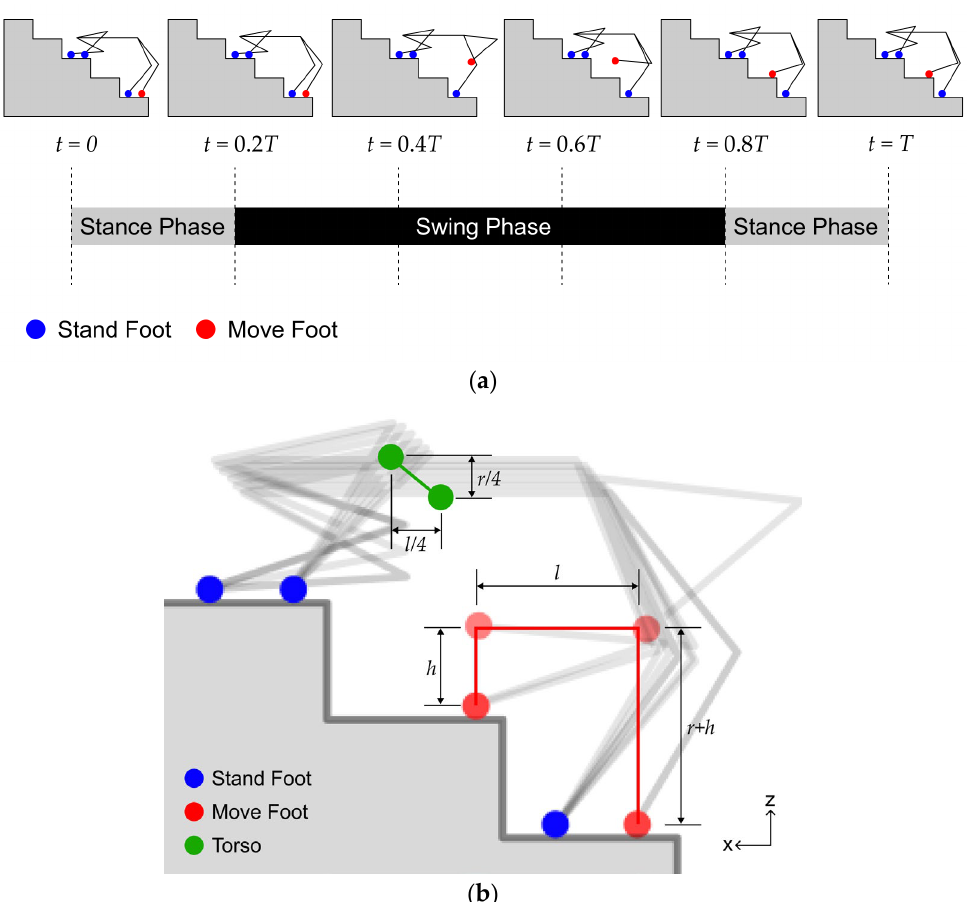
Figure 21. The step circle of each move: ( a ) The process of a step can be divided into five individual time phases, and the robot can form a complete action by linear interpolation between six positions and poses; ( b ) when the robot ascends the stairs, it completes a step of the left hind foot, and the trajectory of the torso and the step foot.